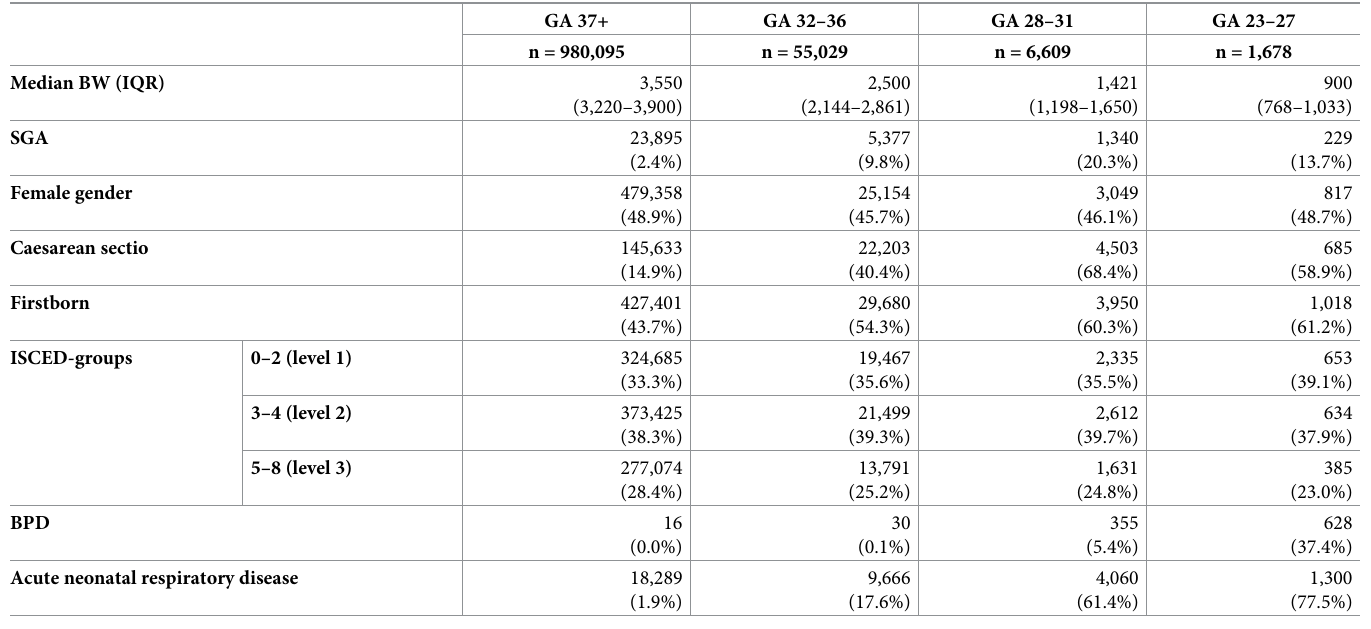
Table 2. Baseline characteristics of final study population in crude numbers (Interquartile Range, IQR, and % respectively). GA 37+ GA